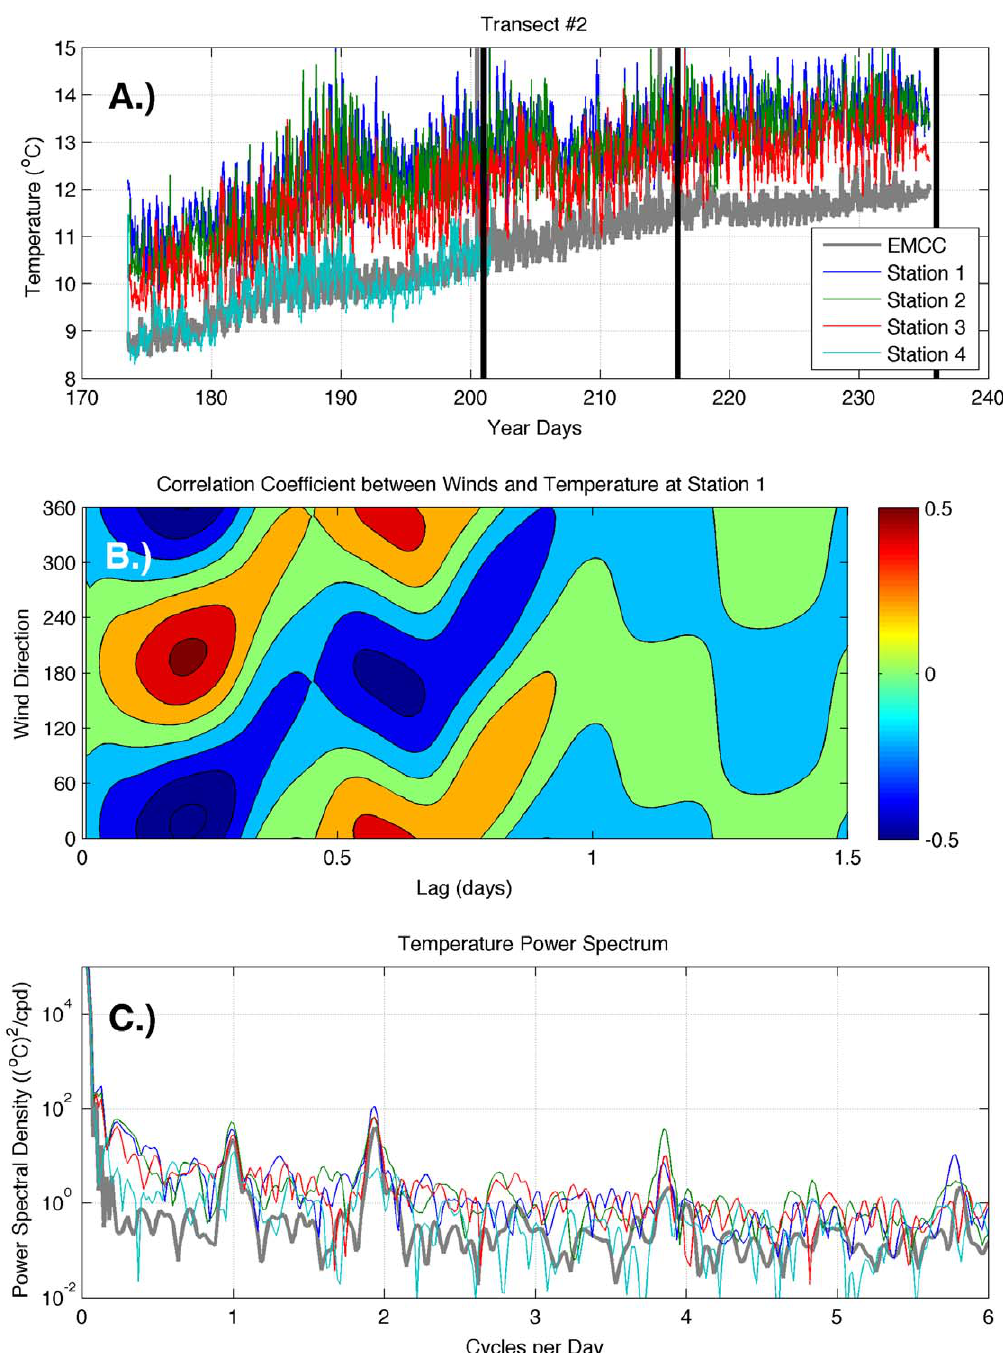
Figure 7. Temperature time series data (A) and analysis (B, C) for transect 2. The two analysis panels present wind-temperature correlations (B), and the power spectra of surface temperature (C). Station numbers begin near the coast and increase offshore. Vertical black lines indicate times of cruises. Note that wind direction refers to the direction that wind is blowing from . doi:10.1371/journal.pone.0048960.g007 back and forth with the tidal currents. The strong velocities and, strophic currents result in immediate downstream transport of therefore, horizontal shear result in more horizontal exchange, less stratification, and greater across-shelf transport between the inshore environment and the EMCC. Once water leaves this region, the flow field expands and is no longer dominated by tides. Although the four cruises produced only a few snapshots of the Instead, buoyancy-generated, topographically-constrained geo- across-shelf and vertical structure, comparison of the across-shelf